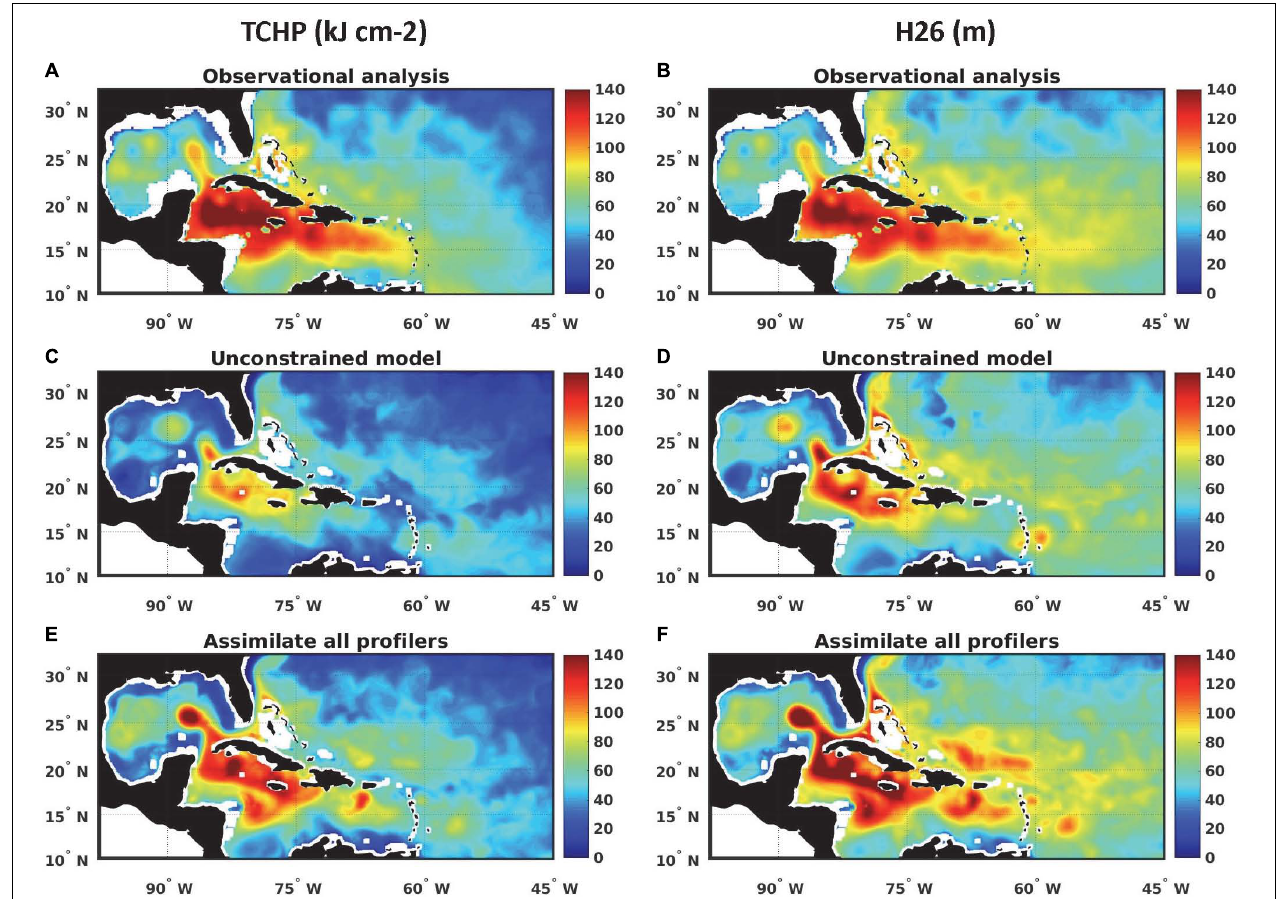
FIGURE 12 | Mean fields of TCHP (A,C,E) and depth of the 26 ◦ C isotherm (H 26 ) (B,D,F) averaged over the time interval 21 August through 8 October 2017. Observation-based estimates are provided by the NOAA/AOML TCHP product (A,B) . Model fields are from an unconstrained simulation (C,D) and from an analysis that assimilated all available data from ocean profilers (Argo floats, underwater gliders, and Alamo floats).